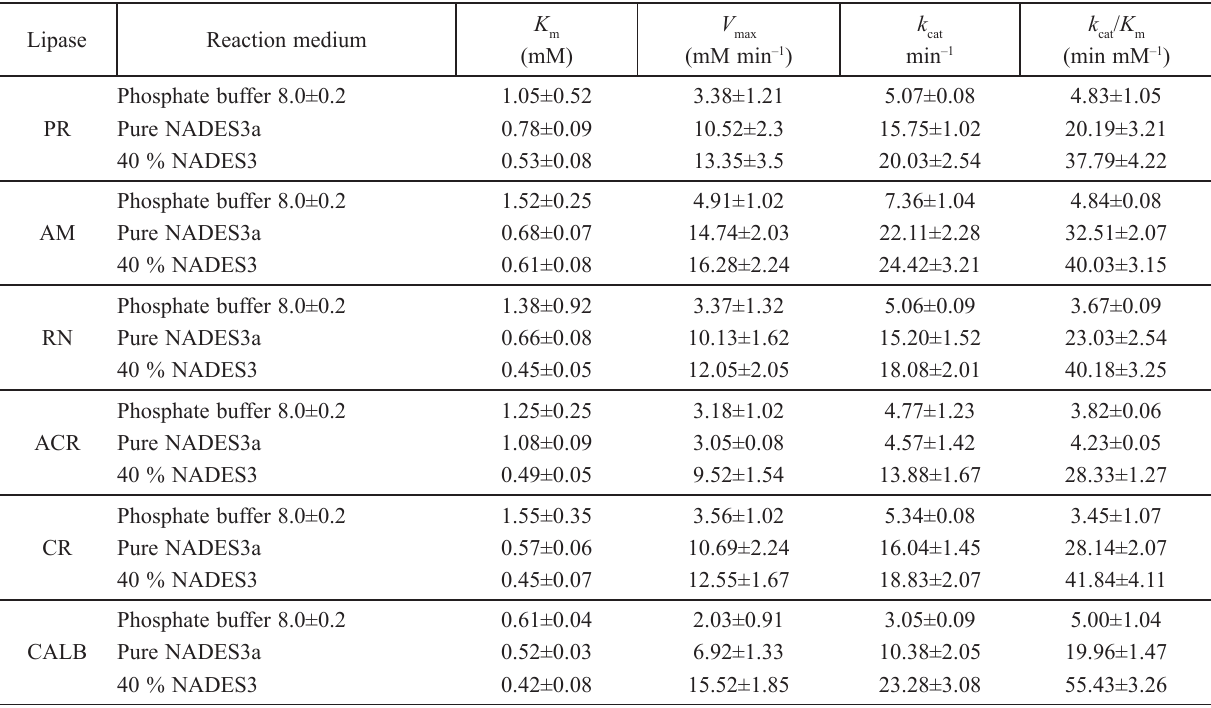
Table 3 – Kinetic parameters of lipases in pNPP substrate solution using different reaction media